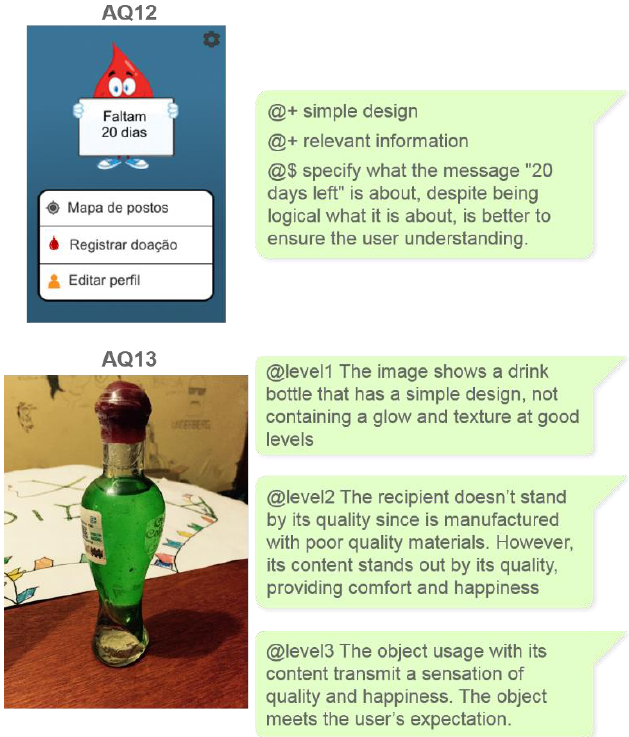
Fig 10. Examples of warm-up messages received with different usage of markers than expected Most students sent their analyses in a single message with the three marks as specified in the warm-ups’ instructions, they also used line breaks to organize multiple markers. It is worth noting that there were different usages of the markers than